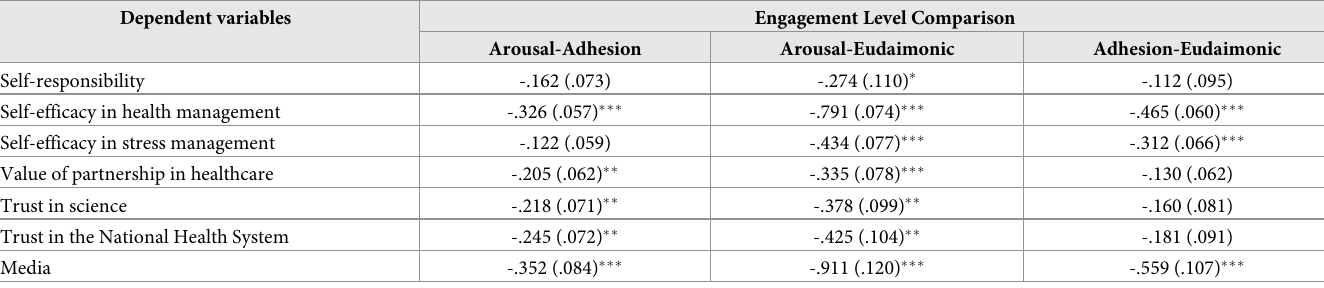
Table 5. Results of Games-Howell